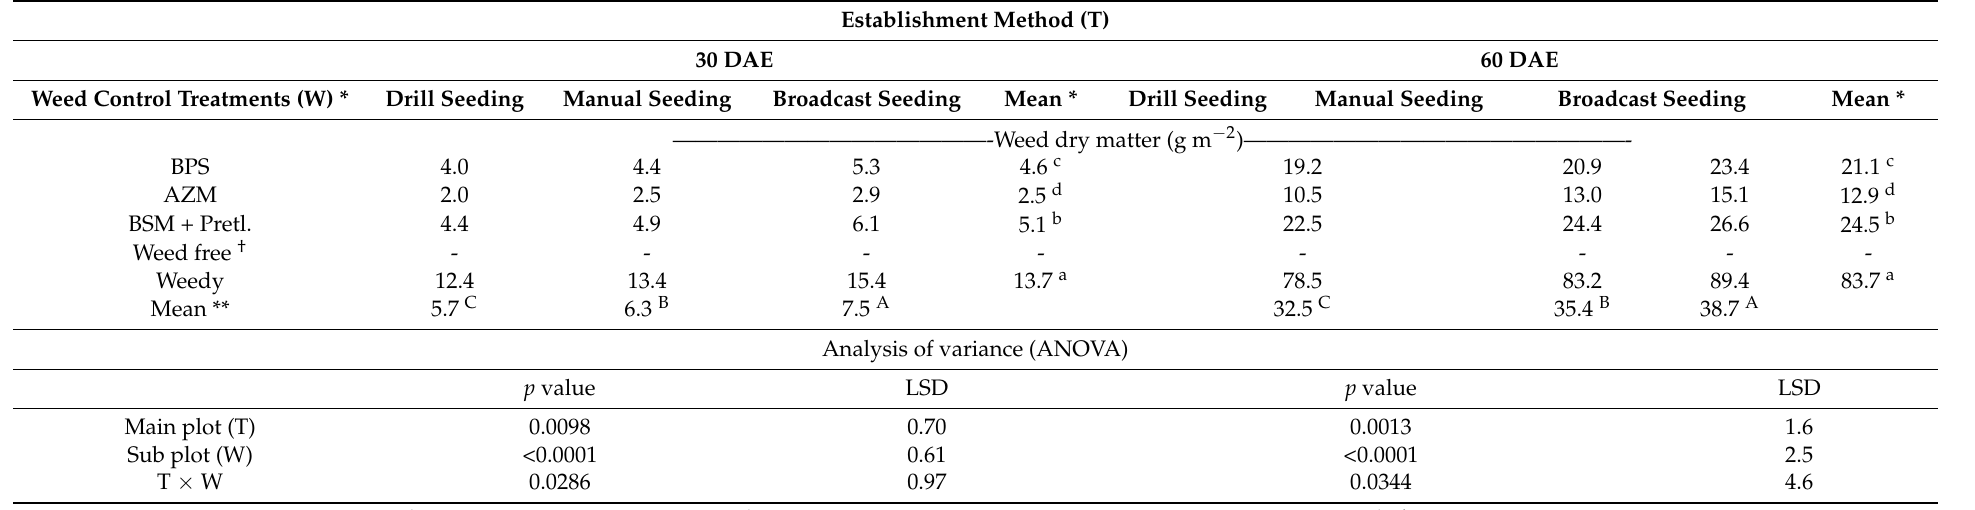
Table 3. Effect of establishment methods and weed control treatments on weed dry weight (g m − 2 ) at 30 and 60 days after emergence (DAE) Cuttack, Odisha (Average of 2015 and 2016) § . Establishment Method